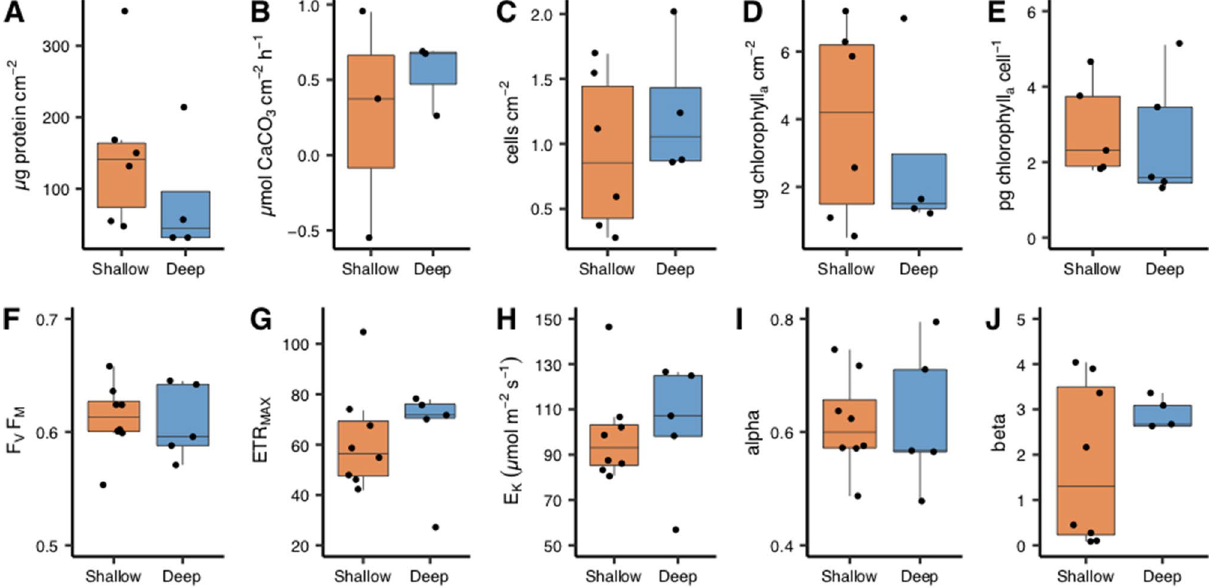
Figure 2. Physiological and photochemical analyses of Oculina patagonica from 30 m (’Deep’, blue boxes) and 2 m (’Shallow’, red boxes) water depth. Subplots in upper panel are ( A ) protein concentration, ( B ) calcification rate, ( C ) algal cell density normalized to protein concentration, ( D ) chlorophyll concentration per skeletal surface area, ( E ) chlorophyll concentration per algal cell. Lower panel ( F ) maximum quantum yield, ( G ) relative maximum electron transport rate, ( H ) saturating irradiance (µmol m −2 s −1 ), ( I ) photosynthetic efficiency at light limiting irradiances, ( J ) the downward slope following maximal electron transport rate. Horizontal black lines within boxes are median values and box limits represent 1st and 3rd quartiles. Whiskers represent 1.5 times the interquartile range. Round black points are individual sample